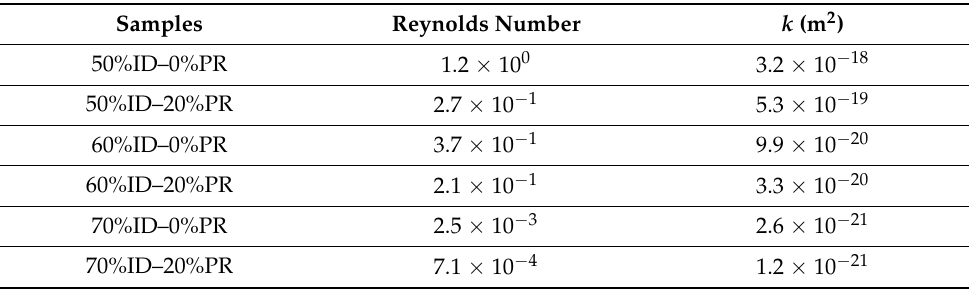
Table 5. Results of the Reynolds number and hydraulic permeability of the permeable part of the